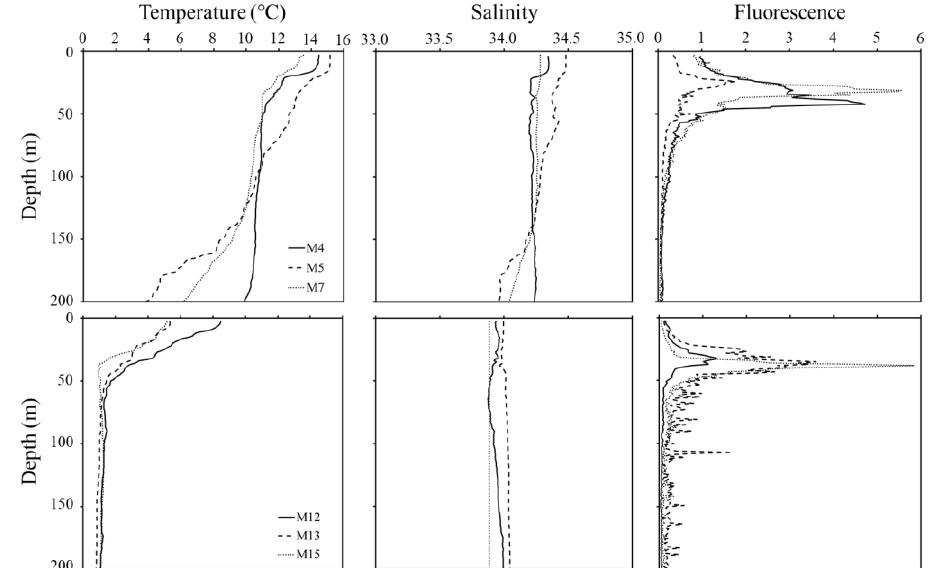
Figure 2. Vertical structures of temperature, salinity, and fluorescence at the southern ( A ) and northern stations ( B ) of the subpolar front.